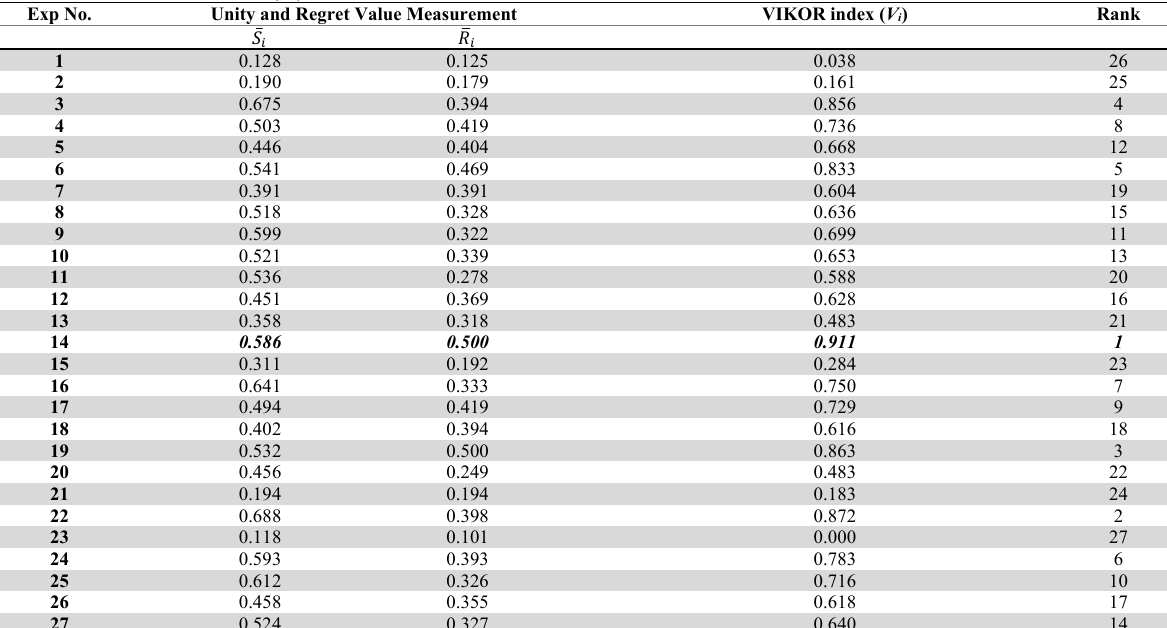
Calculation of VIKOR index ( V i ) Exp